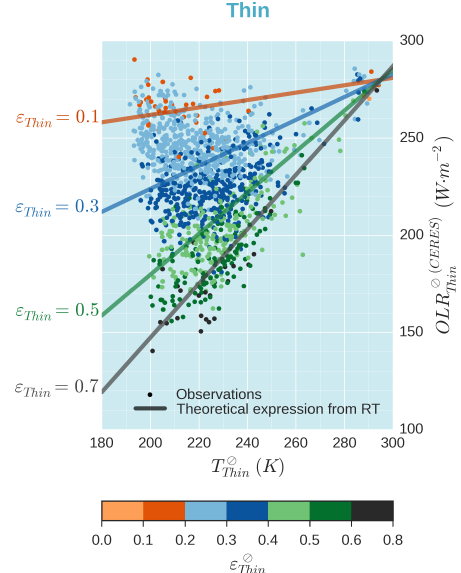
Figure E1. Comparison between observed and lidar-derived OLR, on a CERES footprint scale, as a function of T (cid:11) obtained from CERES (dots) and CALIOP (lines) collocated measurements. Theoretical expressions are from Eq. (4). Same results as in Fig. 6b but only for measurements where OLR (cid:11) is close to 280Wm − 2 selected (OLR (cid:11) clear contribution of T (cid:11) and ε (cid:11) on the OLR. Only nighttime conditions over ice-free oceans for January 2008 are considered. thin thin